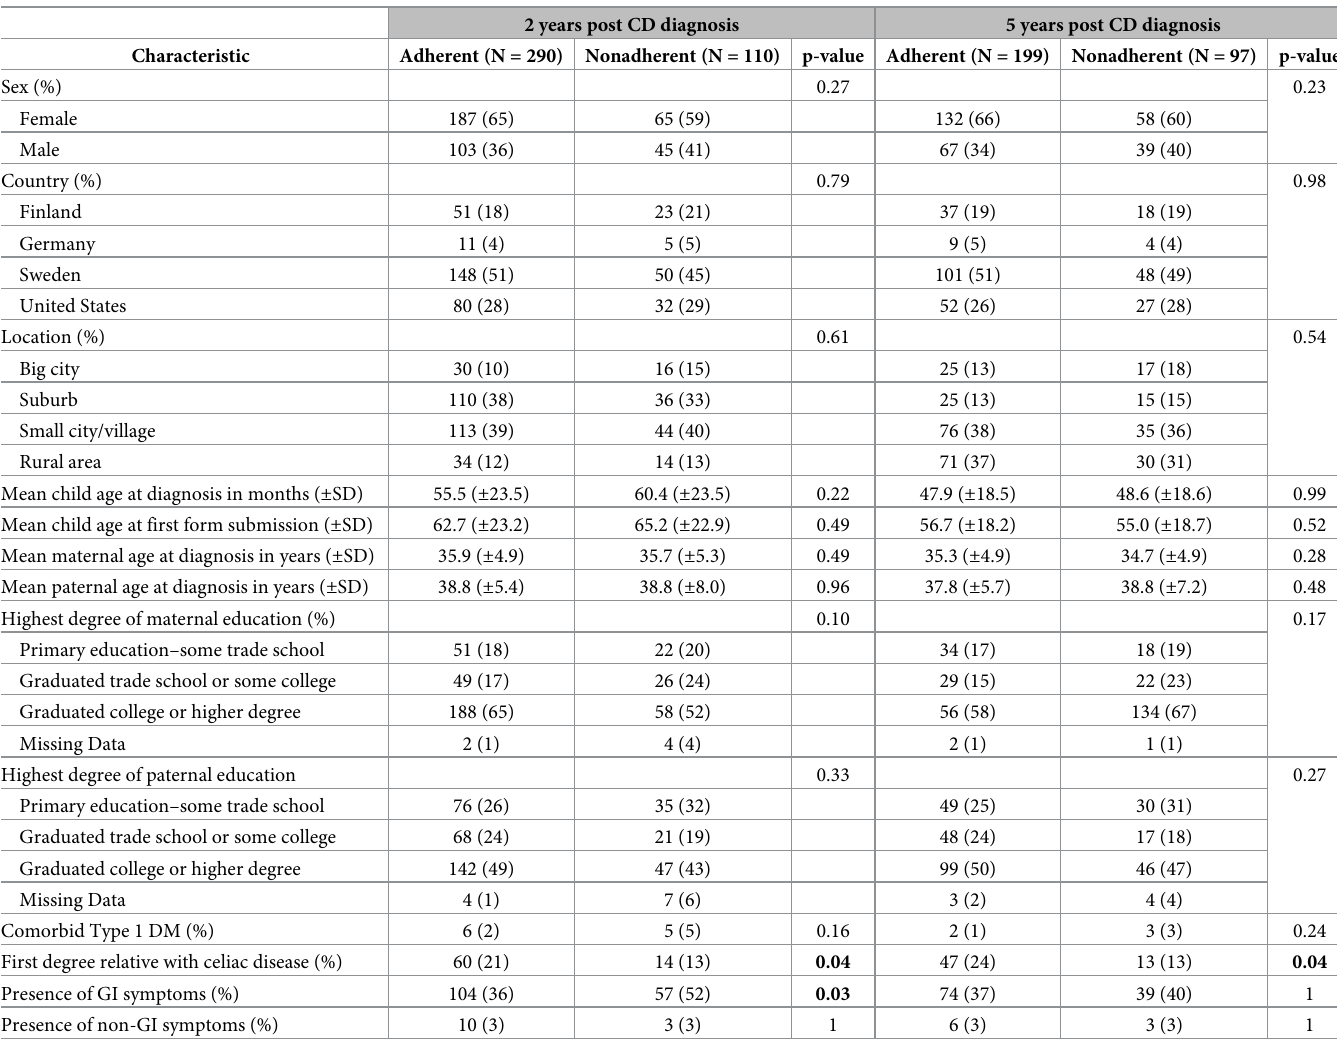
Table 1. Subject characteristics. Subject characteristics at 2 and 5 years post the diagnosis of celiac disease stratified by self-reported gluten-free diet adherence. 2 years post CD